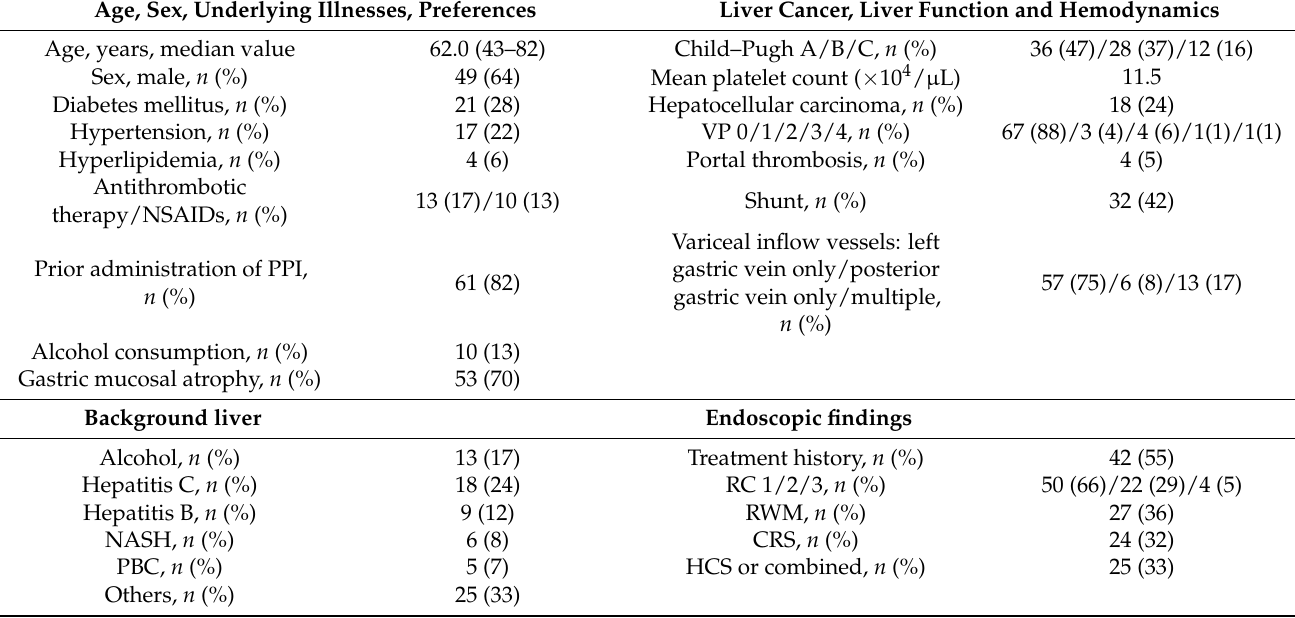
Table 1. Patient characteristics ( n =